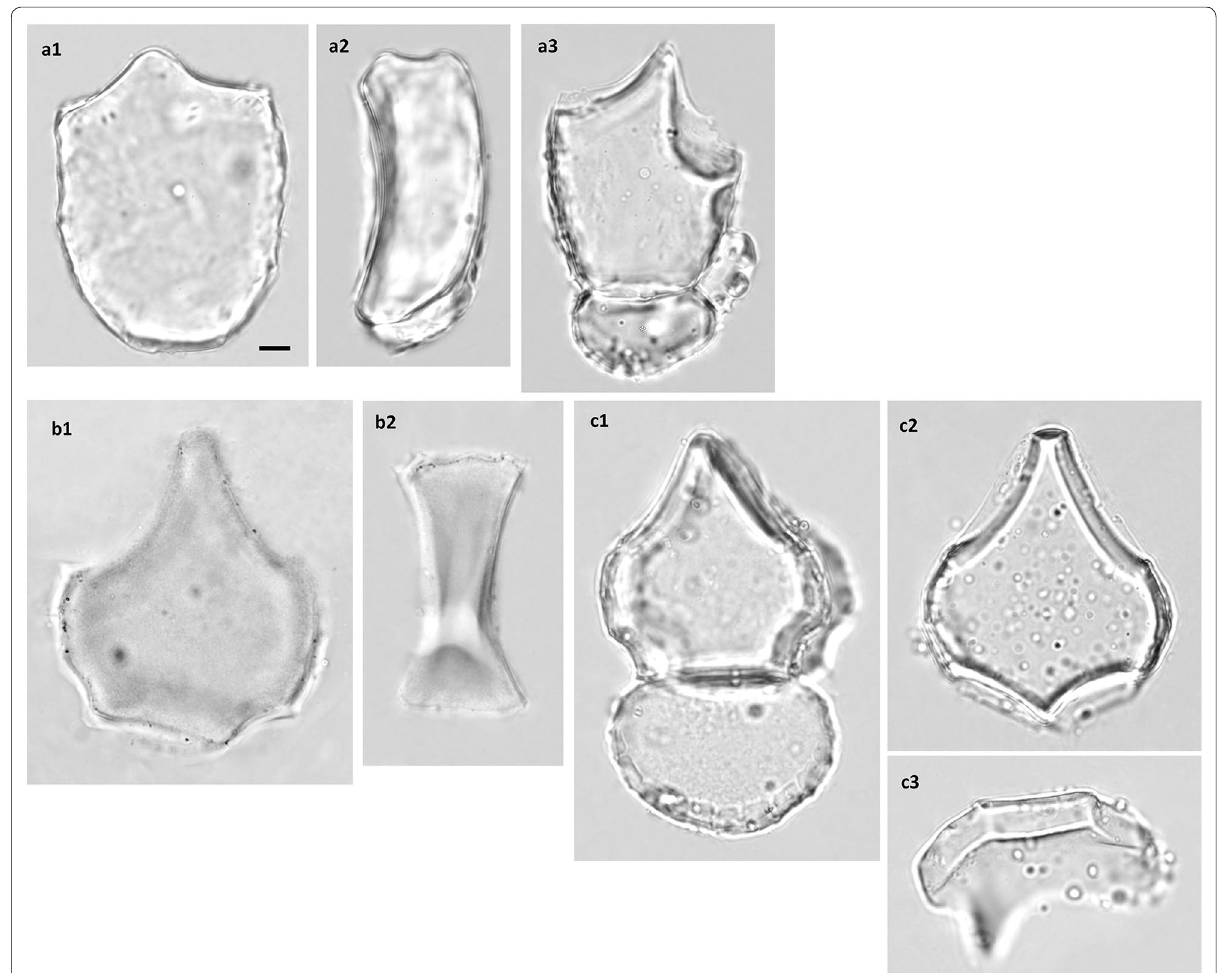
Fig. 12 Bulliform phytoliths of subfamily Arundinoideae. a Phragmites sp.; b A. donax ; c A. formosana . 1 , a3 , c2 , end view; 2 , lateral view; c3 , top view. a3 , c1 , silicified clear cells attached. Bar 10 μm, all pictures are in the same